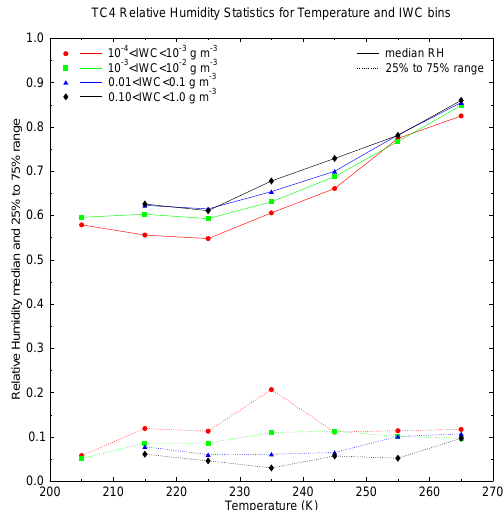
Fig. A5. Relative humidity median and distribution width (25% to 75% range) as a function of temperature for four ice water content